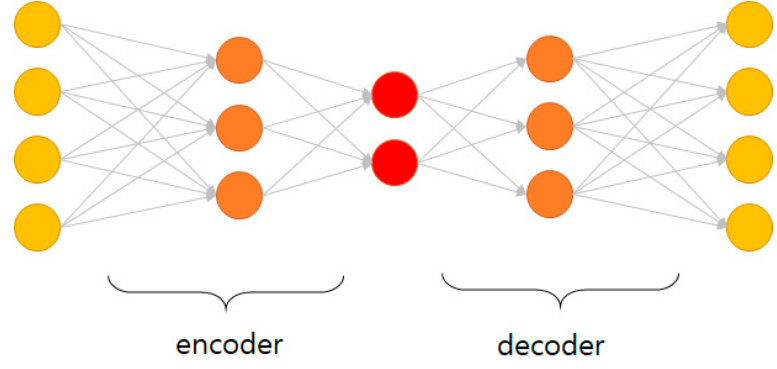
Figure 1. Basic structure of auto ‐ encoder.